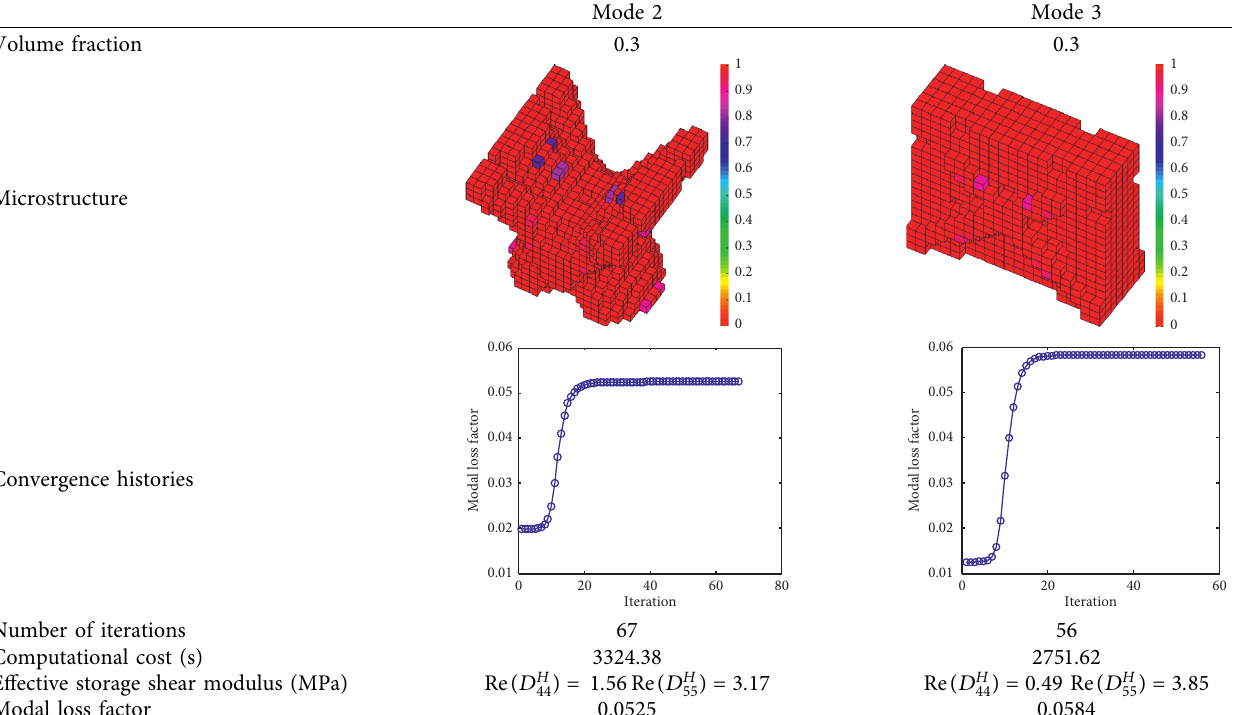
Table 5: Topological designs of viscoelastic damping material microstructures with the same volume fraction. Mode